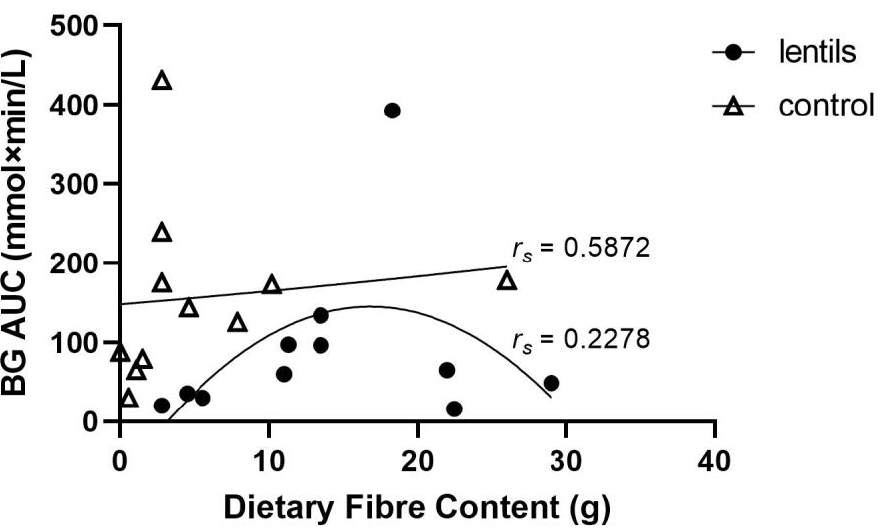
Figure 4. Area under the blood glucose response curve (BG AUC) according to dietary fibre content (g) in lentil treatments and controls. Lentil data best fit a quadratic model ( r s = 0.2278; n = 11; ns ), and control data followed an exponential trend ( r s = 0.5872; n = 11; ns ).